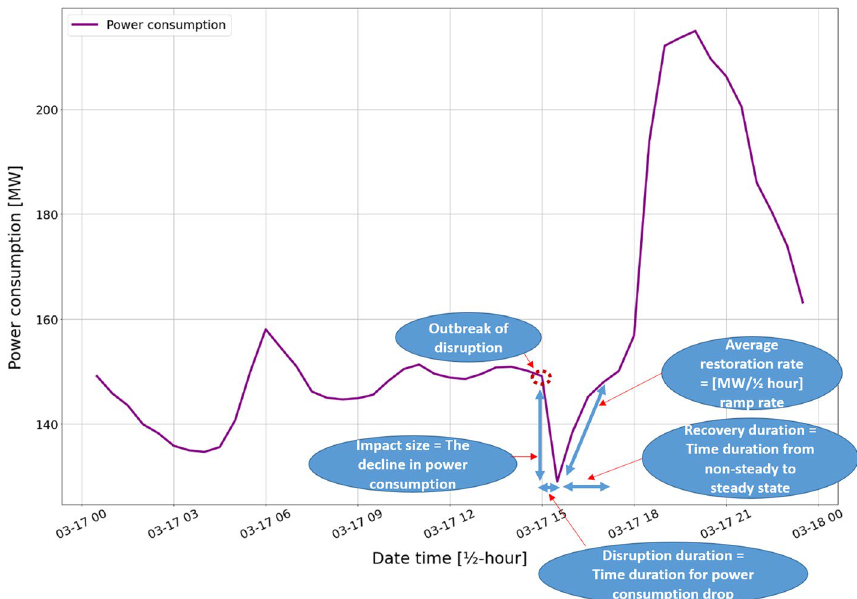
Fig. 19 The electricity consumption during a 5.6 Richter scale earthquake event in Lombok Indonesia, March 17, 2019, at 3 pm